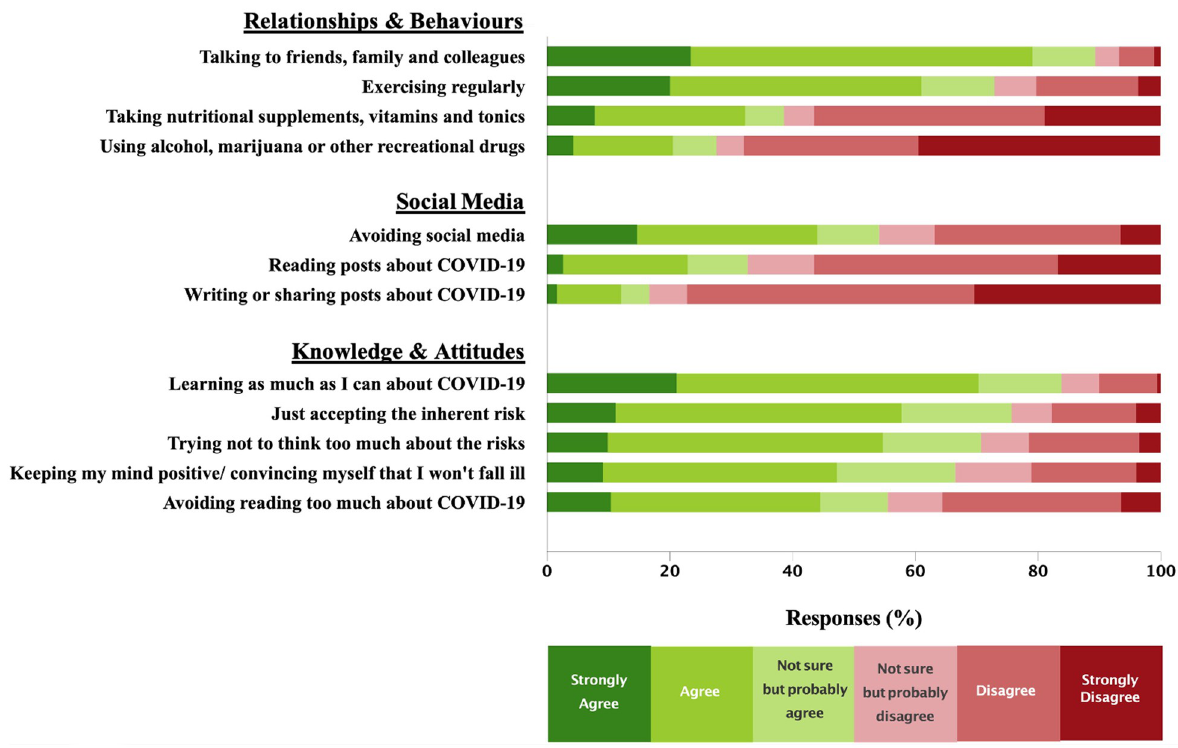
Fig 4. Strategies used by hospital workers to cope with the stresses of the COVID-19 pandemic.